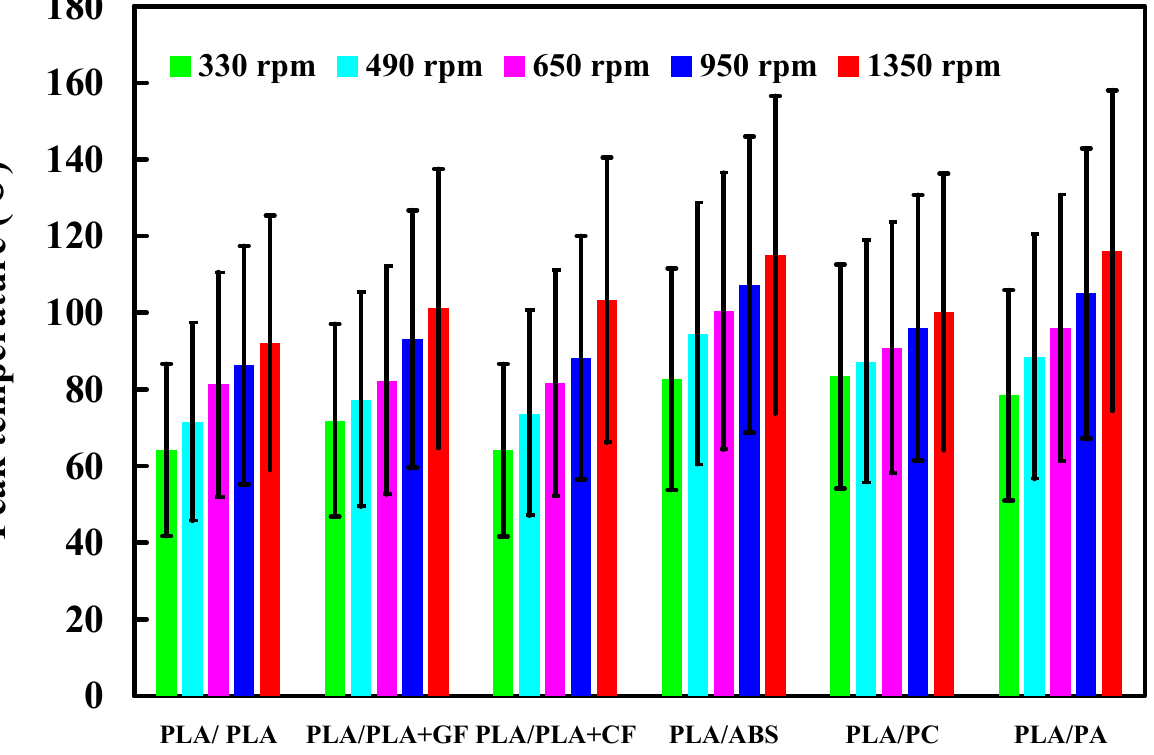
Figure 13. The highest and lowest peak temperatures for FW of six dissimilar materials at five different rotational speeds.